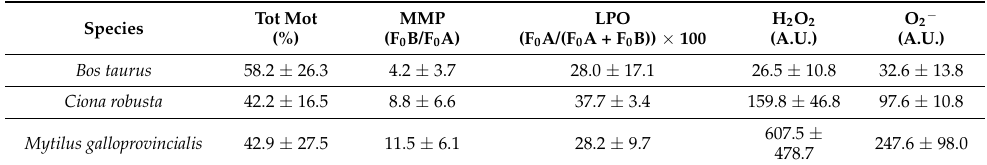
Table 1. Mean ( ± SD) values of total motility (Tot Mot), mitochondrial membrane potential (MMP) evaluated by JC-1, lipid peroxidation (LPO) evaluated by C11-BODIPY 581/591 , intracellular content of hydrogen peroxide (H 2 O 2 ) evaluated by 2 (cid:48) ,7 (cid:48) -dichlorodihydrofluorescein diacetate (H 2 DCFDA) and of superoxide anions (O 2 − ) evaluated by dihydroethidium (DHE) in spermatozoa of the three species examined. Species Tot Mot (%) MMP (F 0 B/F 0 A)